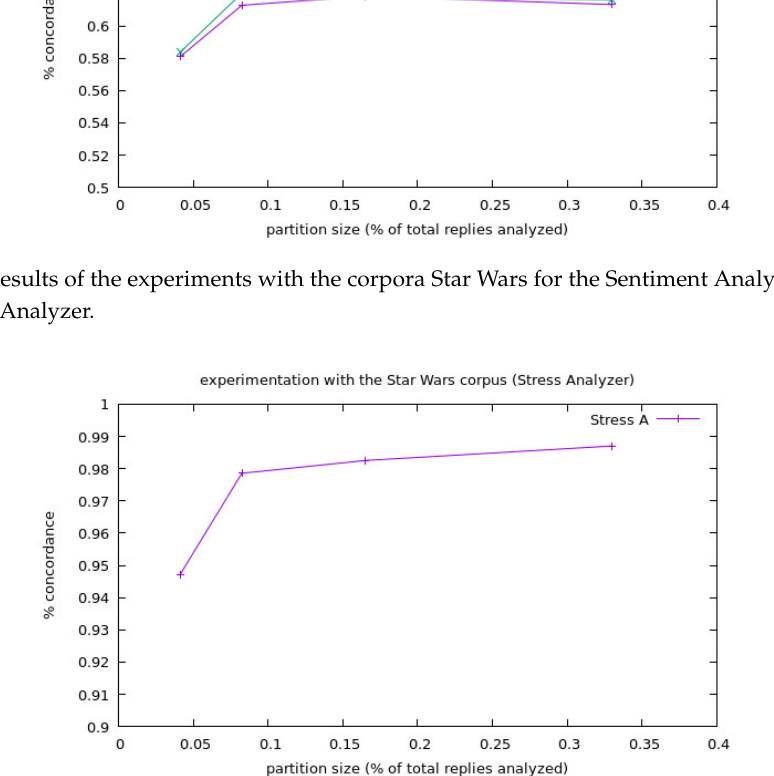
Figure 5. Results of the experiments with the corpora Star Wars for the Stress